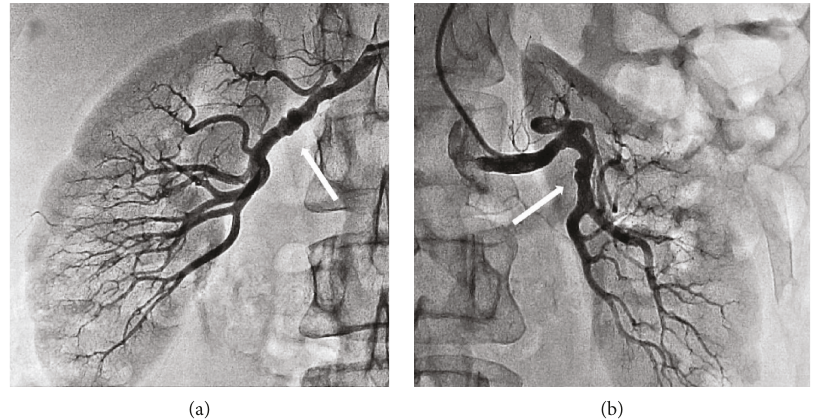
Figure 4: Arteriogram with contrast showing fi bromuscular dysplasia of the middle right and left renal arteries.